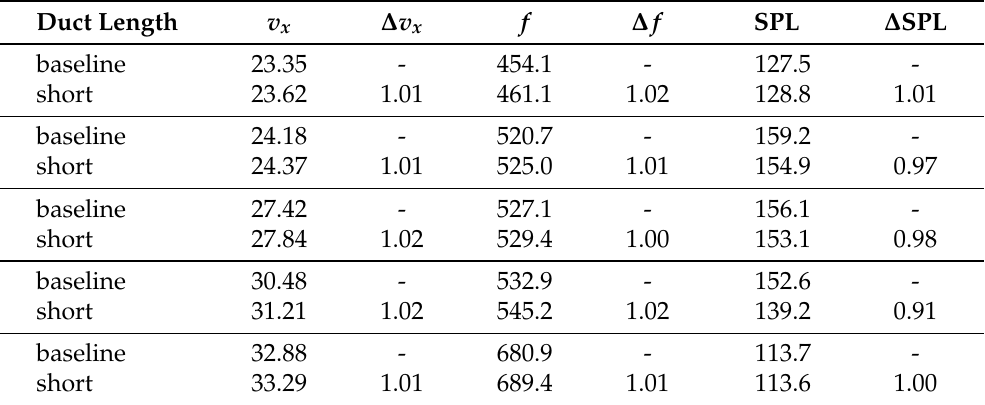
Table 2. Influence of duct length on velocity, shedding frequency, and sound pressure level.